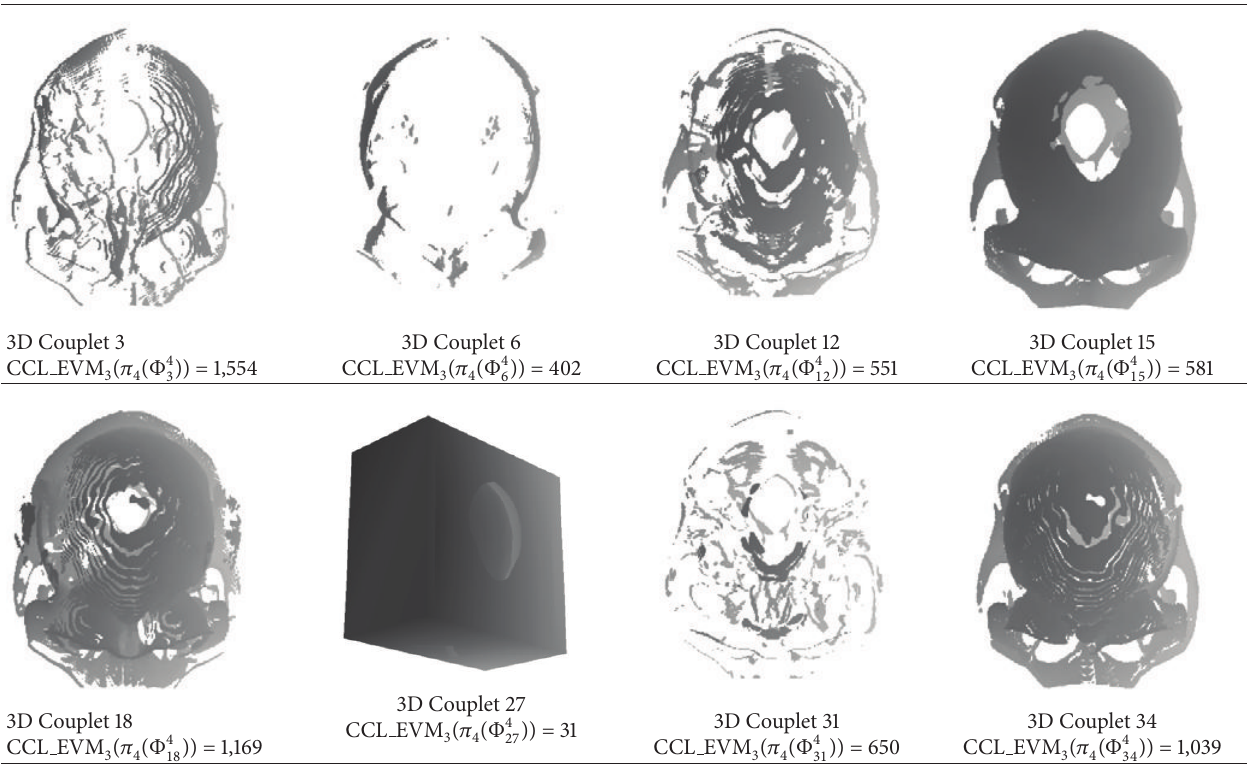
Table 11: Some 3D couplets, perpendicular to color axis, extracted from the 4D-EVM produced by means of Framework 𝑛 D-EVM/Kohonen and associated to dataset CTMonkey